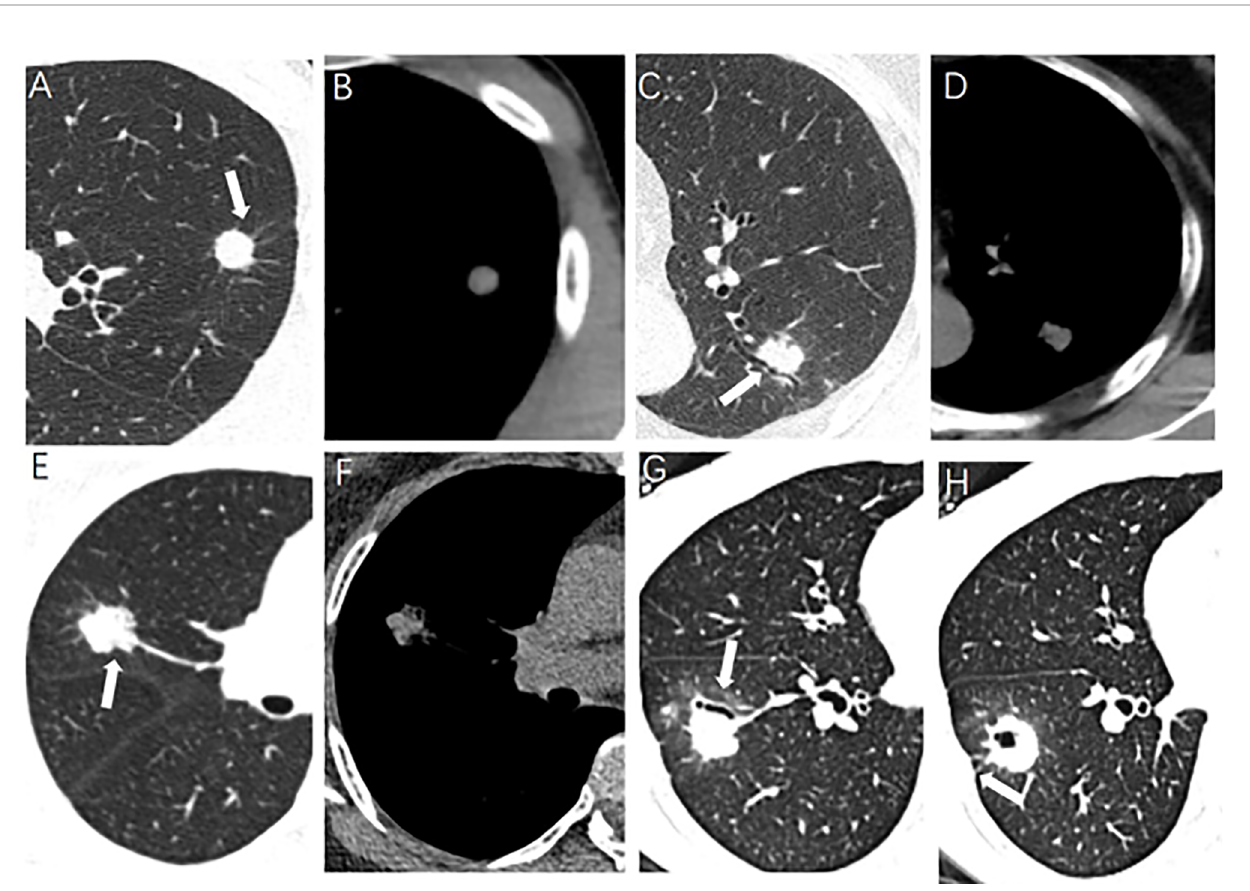
FIGURE 1 | Some CT morphological characteristics of pulmonary solitary solid nodule. (A, B) A 30-year-old male, lung tuberculoma (LTB) with spiculated sign (arrow). (C, D) A 65-year-old female, LTB with air bronchogram (arrow). (E, F) A 62-year-old female, lung adenocarcinoma (LAC) with lobulated sign (arrow). (G, H) A 33-year-old female, LAC with air bronchogram and pleural indentation